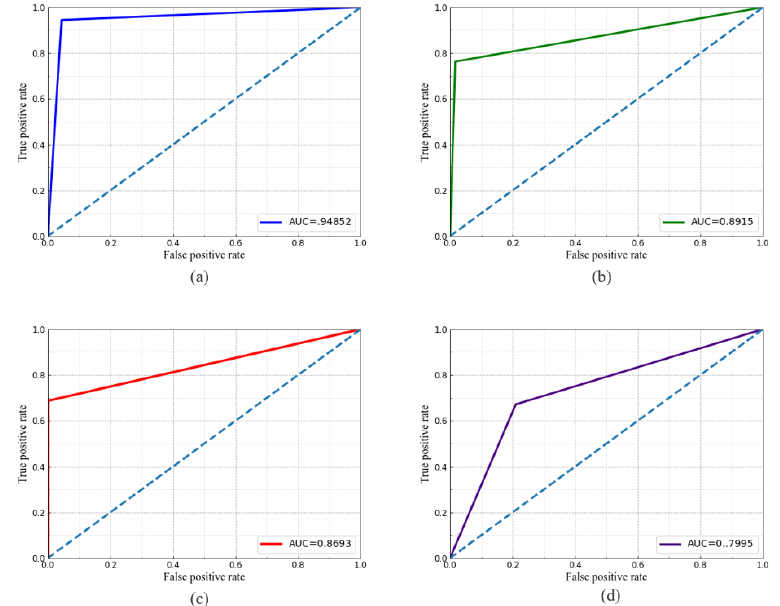
Figure 8. ROC curve of SVM classifier for ( a ) RBF kernel; ( b ) linear kernel; ( c ) polynomial kernel; and ( d ) sigmoid kernel.